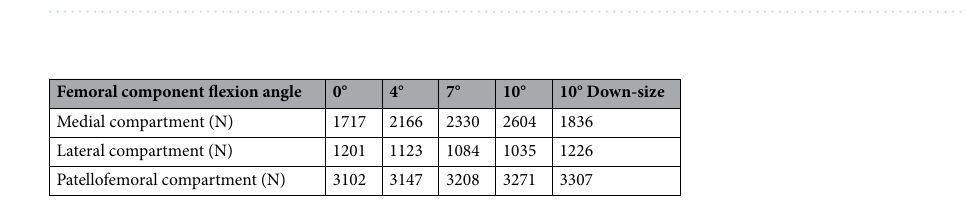
Table 2. Peak contact force of each compartment in